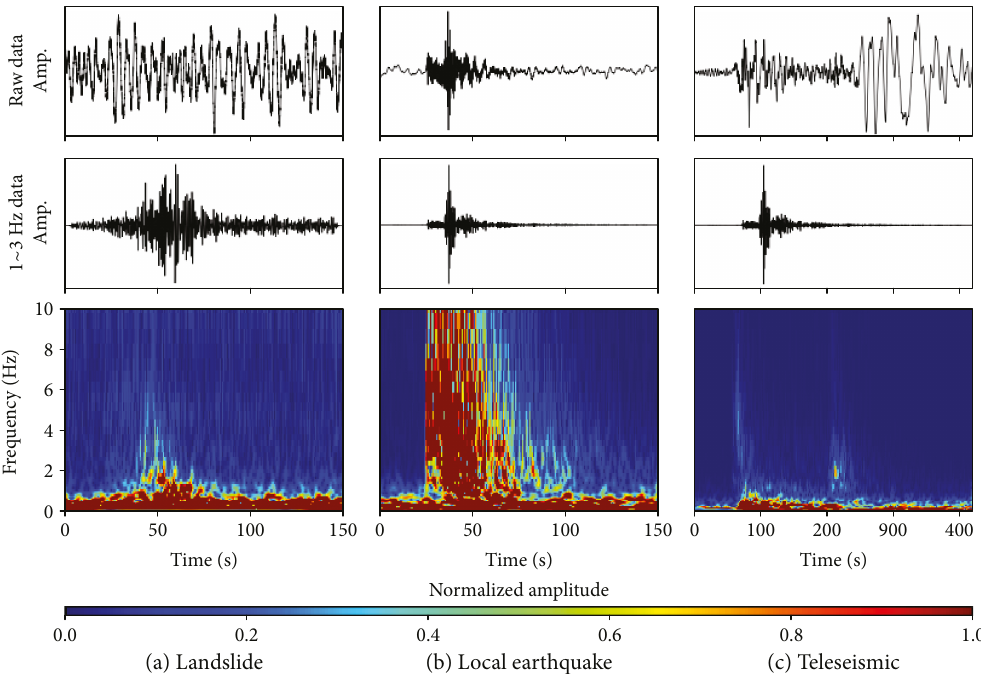
Figure 3: The raw recordings (upper row), 1 ~ 3Hz bandpass- fi ltered waveforms (middle row), and time-frequency spectrum (bottom row) of a landslide (a), a typical local earthquake (b), and a typical teleseismic event (c). The color scale in the bottom row indicates the normalized amplitudes of the raw